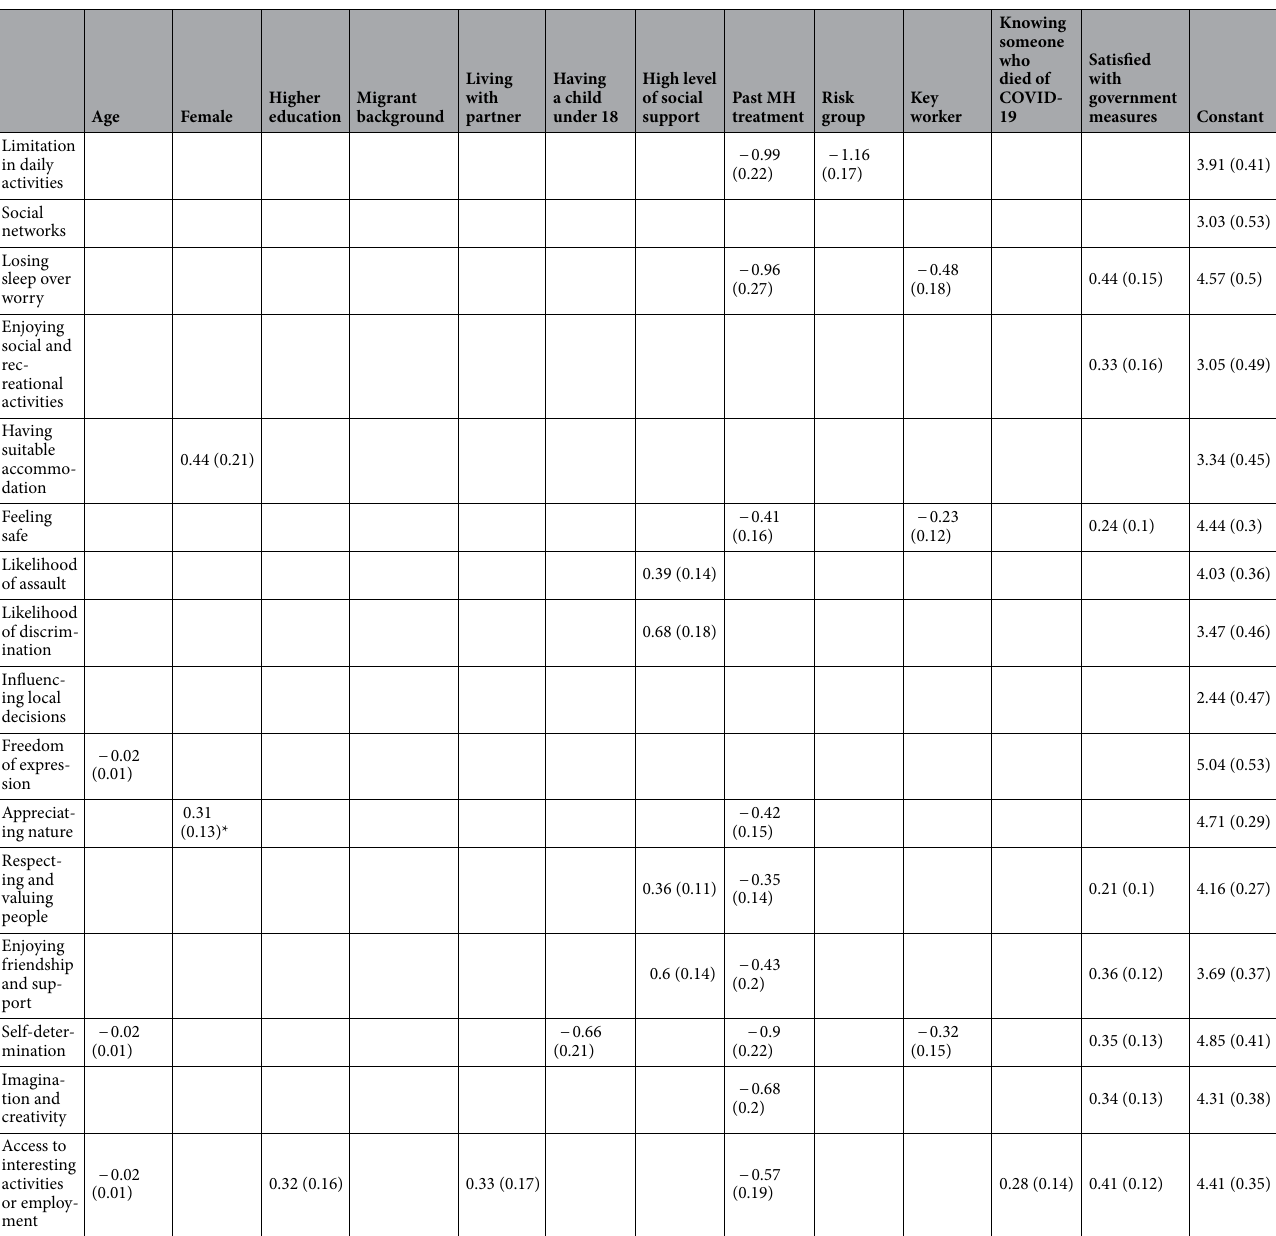
Table 4. Associations between items of the OxCAP-MH instrument across the three lockdowns by sociodemographic characteristics (n = 87). Standard errors (SE) in parentheses; Only statistically significant (p < 0.05) associations displayed; OxCAP-MH—Oxford CAPabilities questionnaire-Mental Health; Level of social support was based on MSPSS score (scores ranging from 1 to 5 were categorised as moderate to low level of support; whilst scores from 5.1 to 7 could be considered high level of